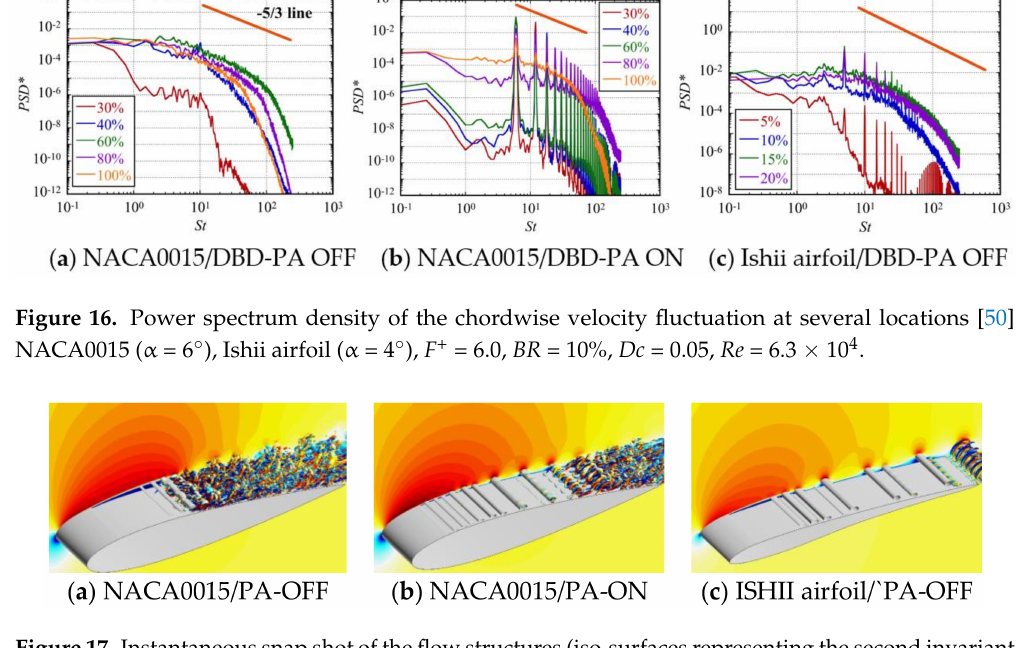
Figure 17. Instantaneous snap shot of the flow structures (iso-surfaces representing the second invariant of the velocity gradient tensor colored with the chordwise vorticity) NACA0015 ( α = 6 ◦ ), Ishii airfoil ( α = 4 ◦ ), Re = 6.3 × 10 4 , F + = 6.0, Dc = 0.05, BR =